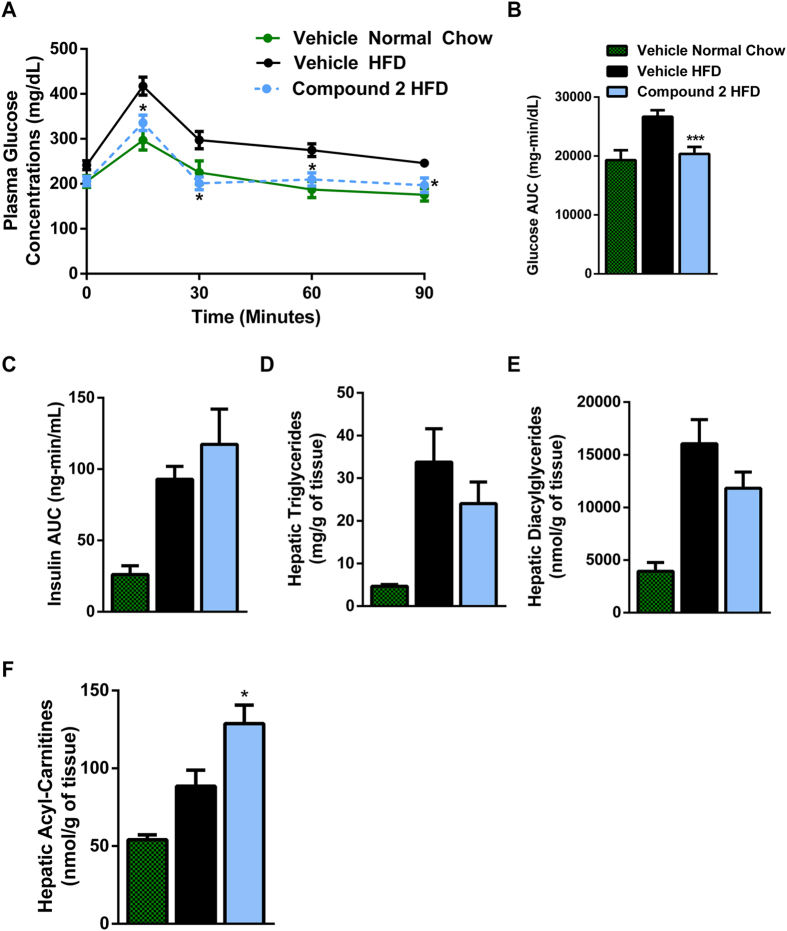
Effect in mice treated chronically with 2.(A) Plasma glucose concentrations during an OGTT following treatment for 20 days with 250 mg/kg BID compound 2 (*P < 0.05, n = 5 normal chow, n = 10 for each HFD group). (B) Plasma glucose concentrations AUC (***P < 0.005, One-way ANOVA – Dunnett’s post hoc test). (C) Plasma insulin concentrations AUC. (D–F) Hepatic triglycerides, diacylglycerides, and acyl-carnitines from livers of mice treated with 250 mg/kg BID compound 2 for 21 days (n = 5 normal chow, n = 10 for each HFD group, *P < 0.05, One-way ANOVA – Dunnett’s post hoc test).